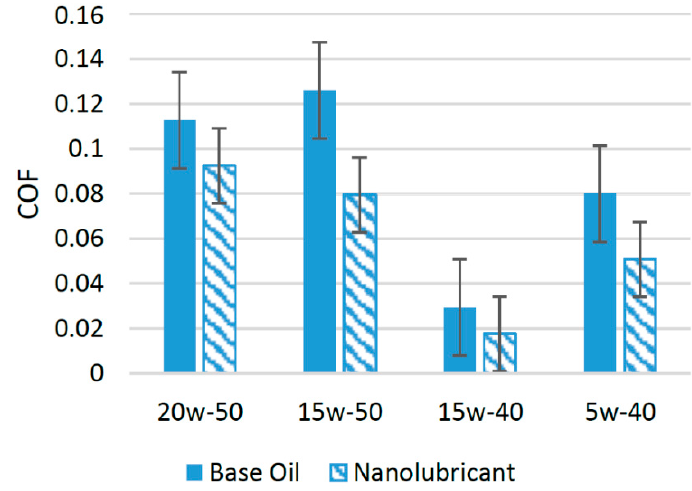
Figure 12. Effect of SiO 2 NPs on the friction performance of synthetic